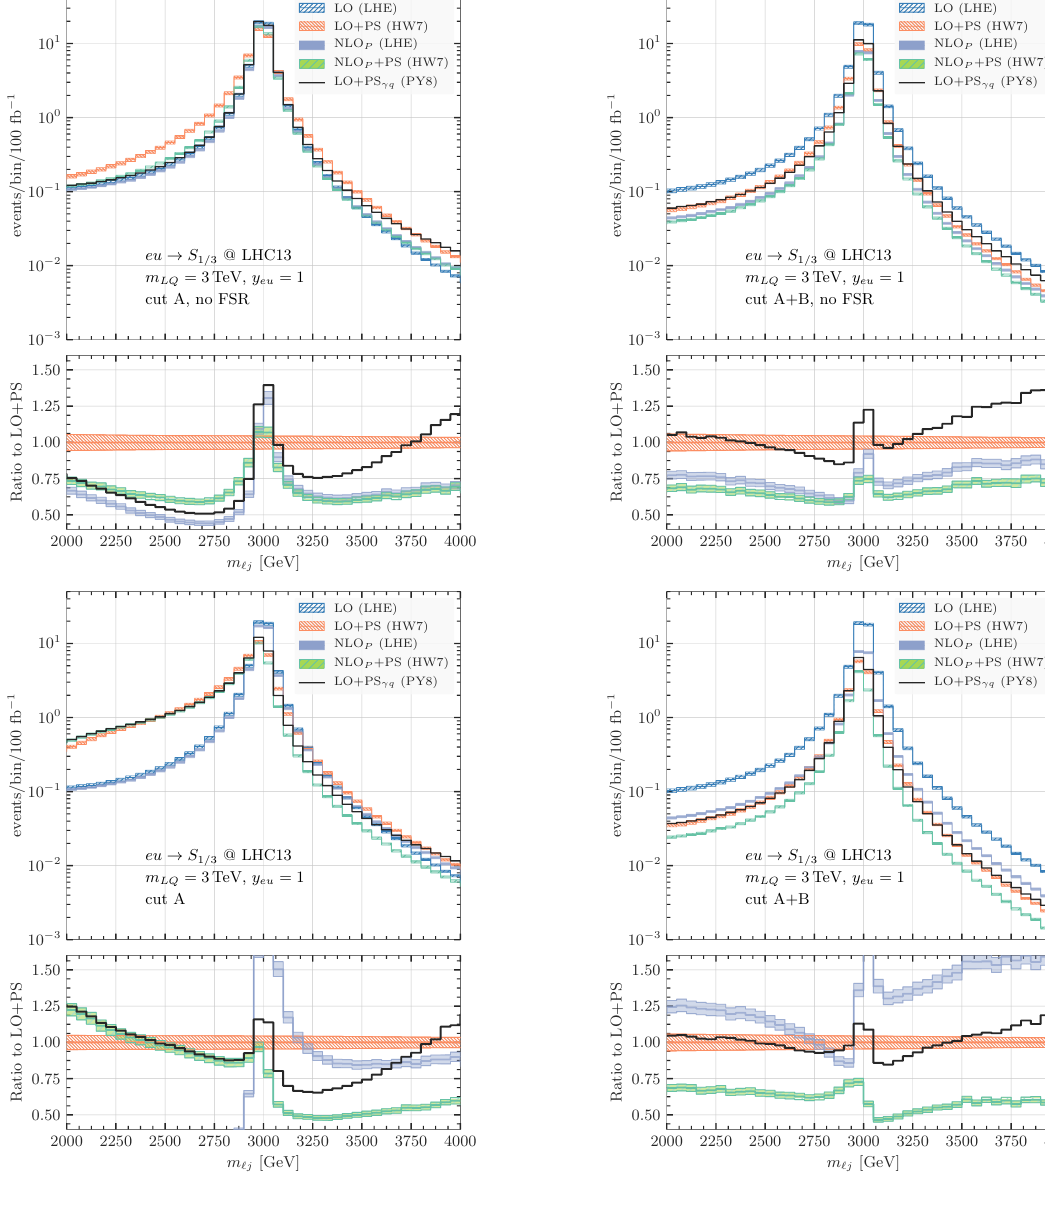
Figure 6 . Invariant mass distribution of the leading- p T lepton and jet system, m ‘j , in a model of resonant s -channel leptoquark production through lepton-quark fusion at the LHC. In each figure, the various predictions correspond to generators at different accuracy, as explained in the main text, while the bottom panel contains the ratio to the LO+PS (HW7) one. We display results for the number of events requiring only cut A (left) and the combination cut A+B (right). Radiation from the decay products is disabled in the two top